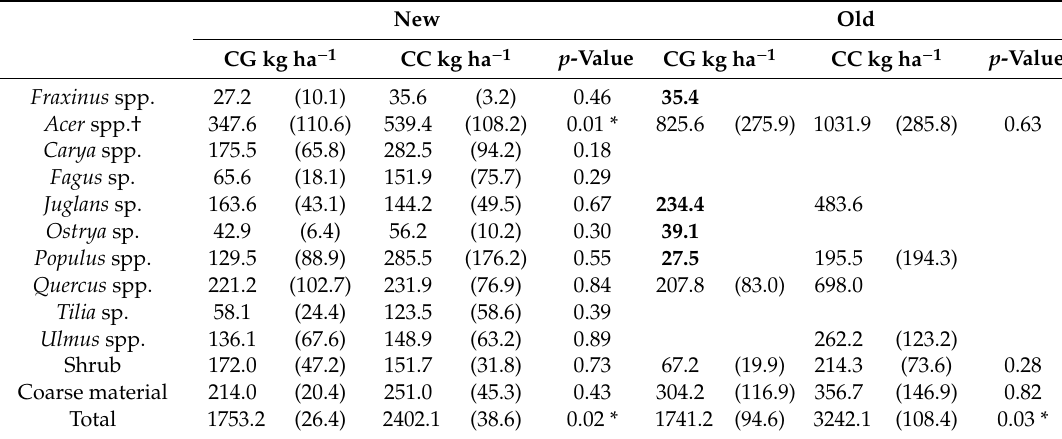
Table 3. Mean ( ± SEM) C flux of litterfall (kg ha − 1 ) in the Canopy Gap (CG) plots and Canopy Closed (CC) plots for the new and old infestation sites.